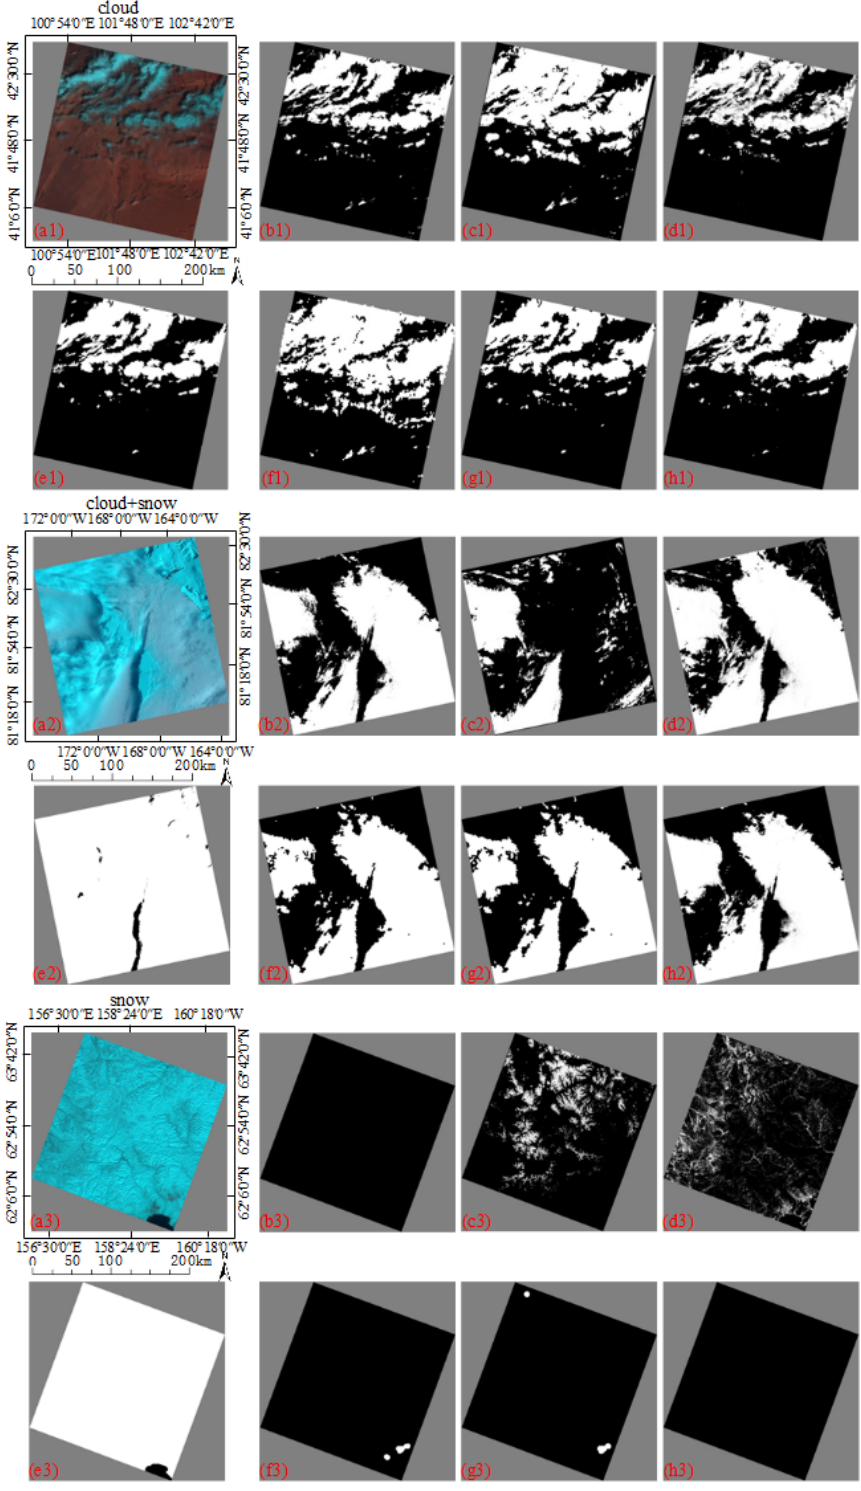
Figure 6. Visual comparisons of cloud detection results of different methods. ( a1 – a3 ) Original color composite images ( a1 : LC81330312013202LGN00; a2 : LC80211222013361LGN00; a3 : LC81030162014107LGN00). ( b1 – b3 ) Ground truth. ( c1 – c3 ) Zhu’s method. ( d1 – d3 ) Yang’s method. ( e1 – e3 ) Li’s method. ( f1 – f3 ) Shi’s method. ( g1 – g3 ) Goff’s method. ( h1 – h3 ) The proposed